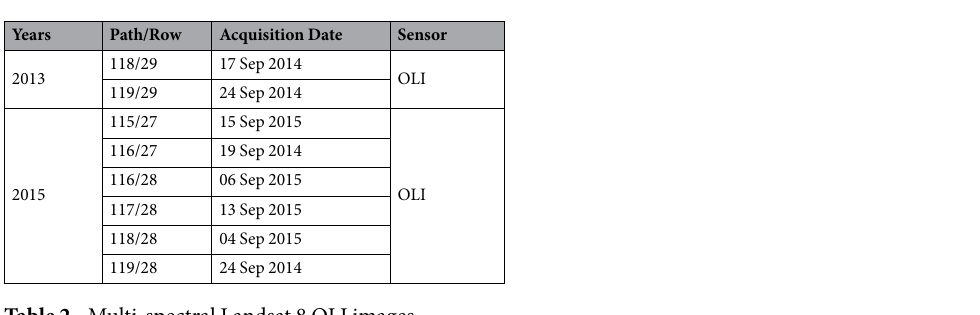
Table 2. Multi-spectral Landsat 8 OLI images.